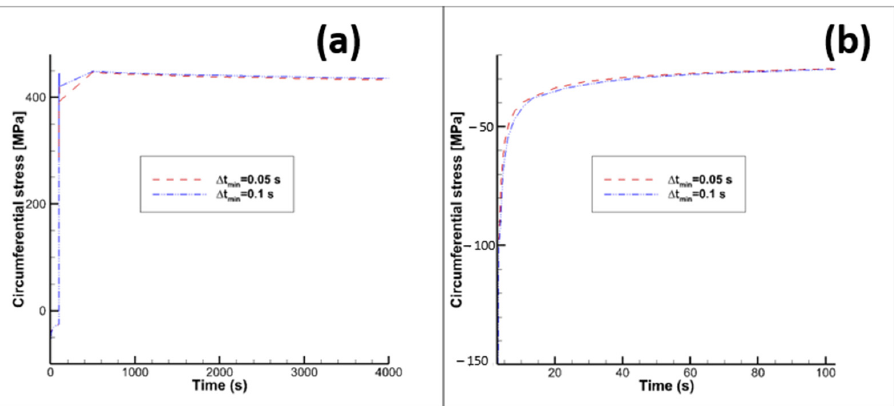
Figure 9. Circumferential stress vs time. ( a ) overall 1st cycle, ( b ) close up of hot phase 1st cycle. Orange curve (“previous”): ∆ t min = 0.1 s for the hot phase and ∆ t min = 0.006 s for the purging phase; blue curve (“new”): ∆ t min = 0.05 s for the hot phase and ∆ t min = 0.003 s for the purging